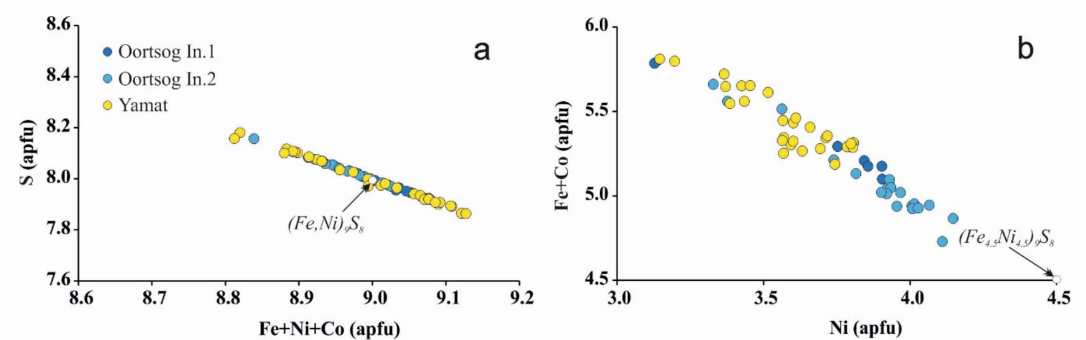
Figure 10. Chemical compositions of pentlandites in rocks of the Oortsog and Yamat massifs: a Fe + Ni + Co vs. S; b Ni vs. Fe + Co. apfu—atoms per formula